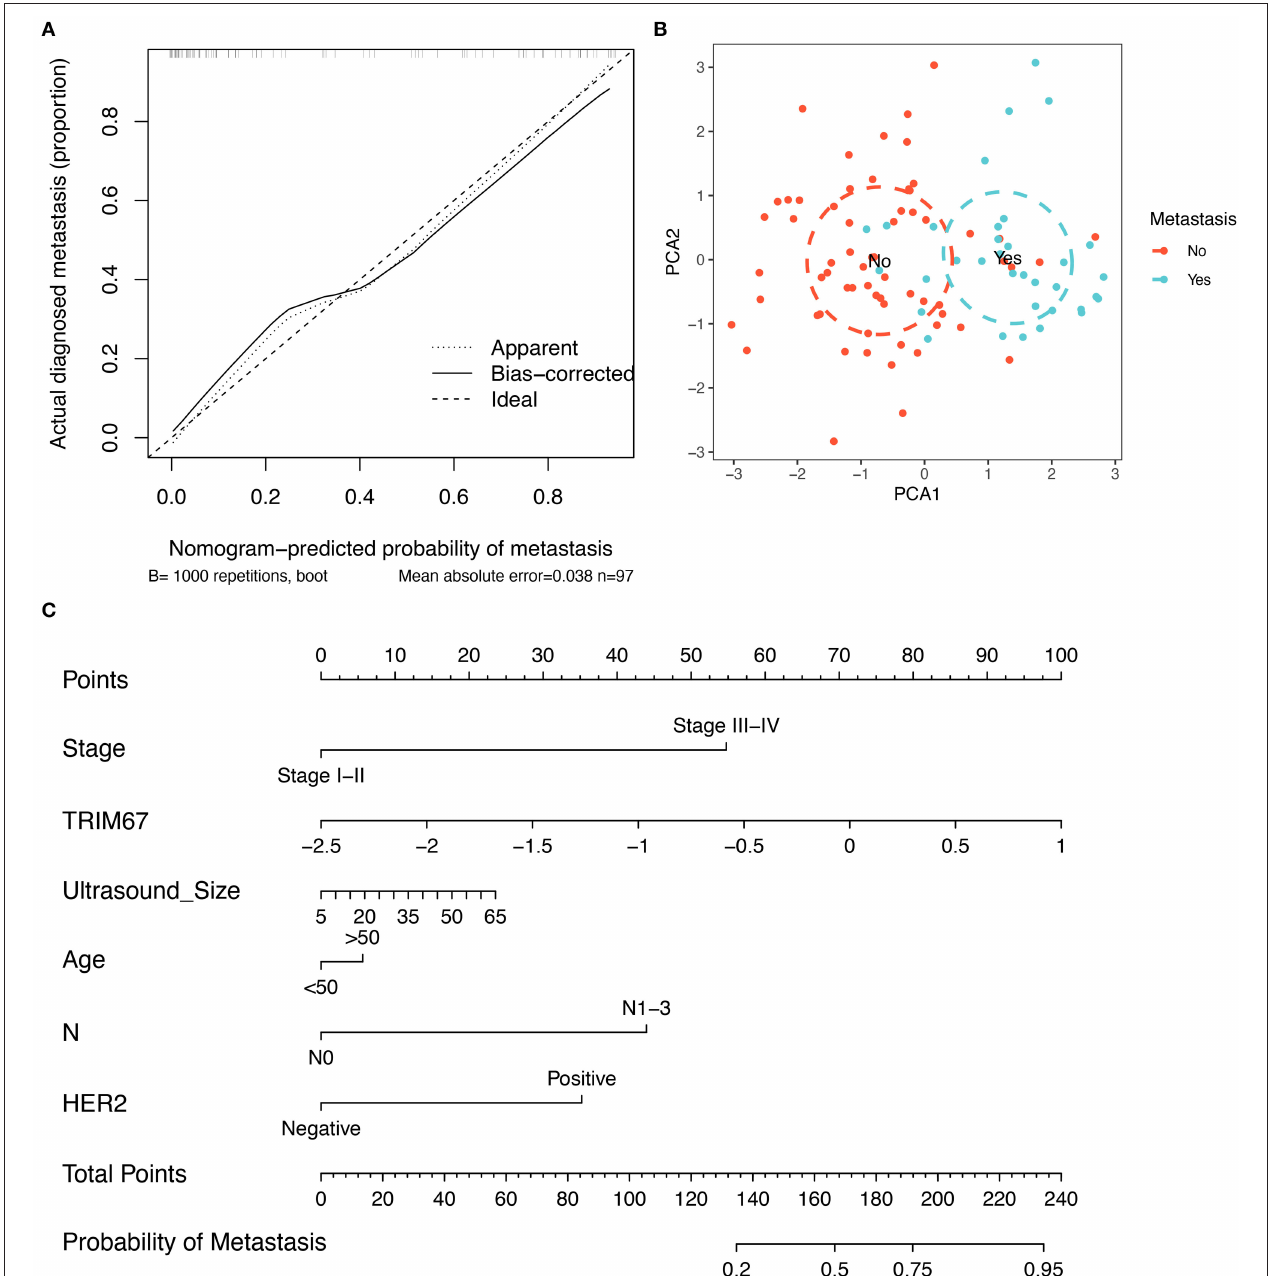
FIGURE 4 | Construction of a clinical prediction model for tumor metastasis. (A) The correction curves show that the predicted outcomes of this clinical prediction model are in good agreement with the true outcomes of the patients; (B) The PCA visualization demonstrates the efficacy of using the six variables to differentiate patients with breast cancer who developed tumor metastases; (C) The nomogram, constructed based on a clinical prediction model, allows an assessment of the likelihood of tumor metastasis based on these six variables.